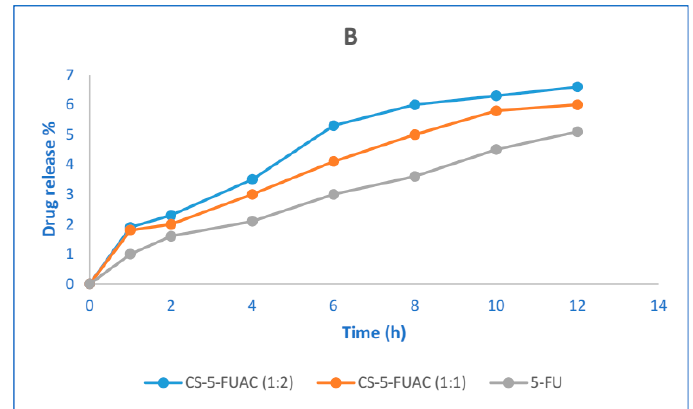
Figure 6. Stability test of CS-FUAC conjugates and free drug, 5-FU at ( A ) acidic pH 1.2, and ( B ) pH 7.4 buffer. All values are expressed as mean ± SD (n = 3).